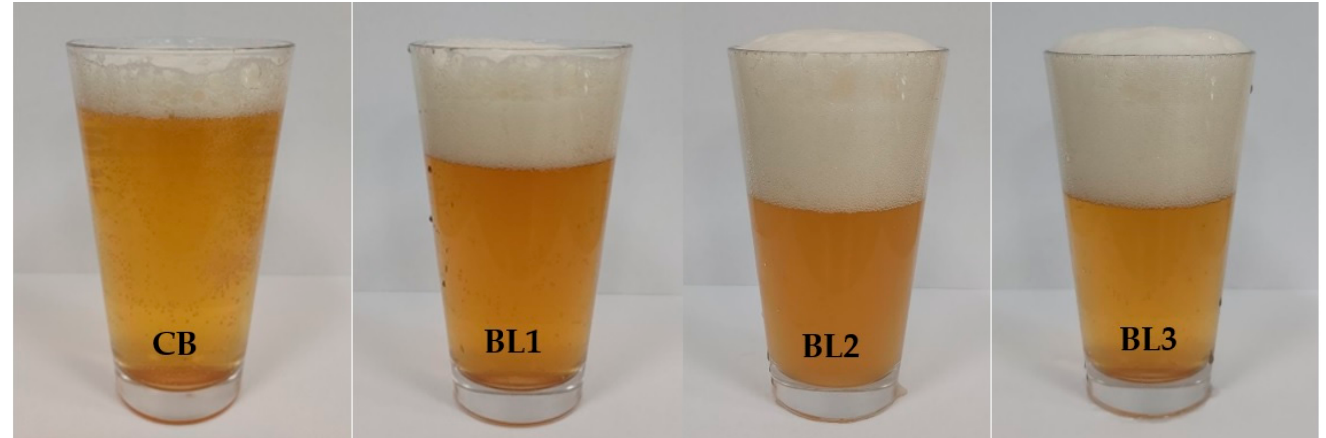
Figure 1. Appearance of the wheat beers obtained from left: control (CB), wheat beer with 1% m / v (BL1), 2.5% m / v (BL2) and 5% m / v (BL3) lemongrass addition.